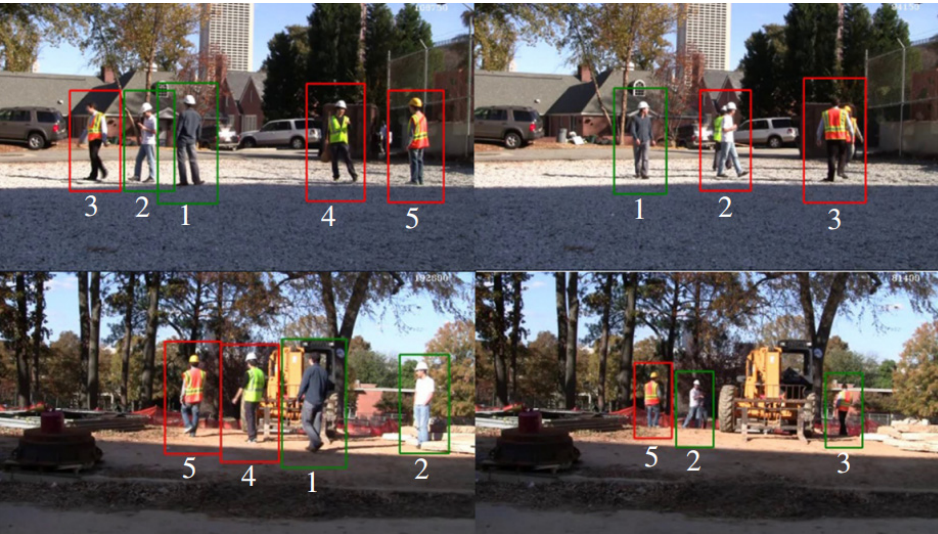
Figure 9. Example of the HOG-based human body detection in the foreground regions. Reproduced with permission from ref. [45]. Copyright 2012 Elsevier.